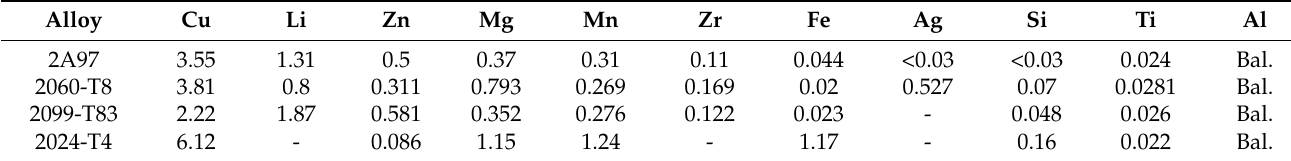
Table 1. The chemical constituents of the alloys (wt.%).